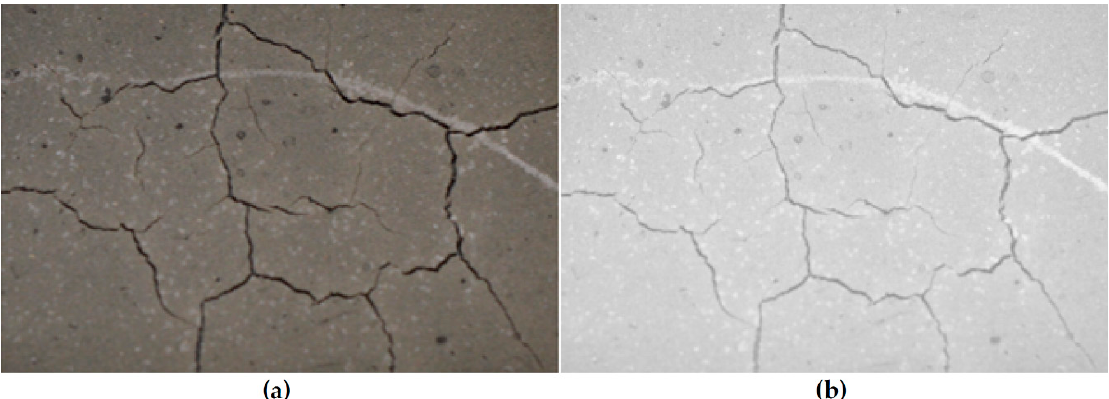
Figure 5. ( a ) Original image and ( b ) grayscale image after intensity adjustment.